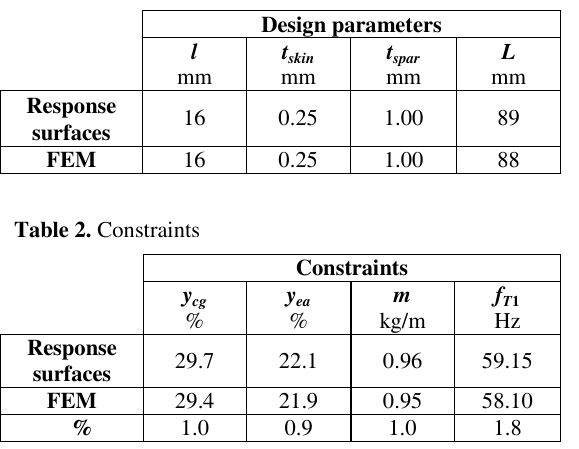
Table 1. Design parameters